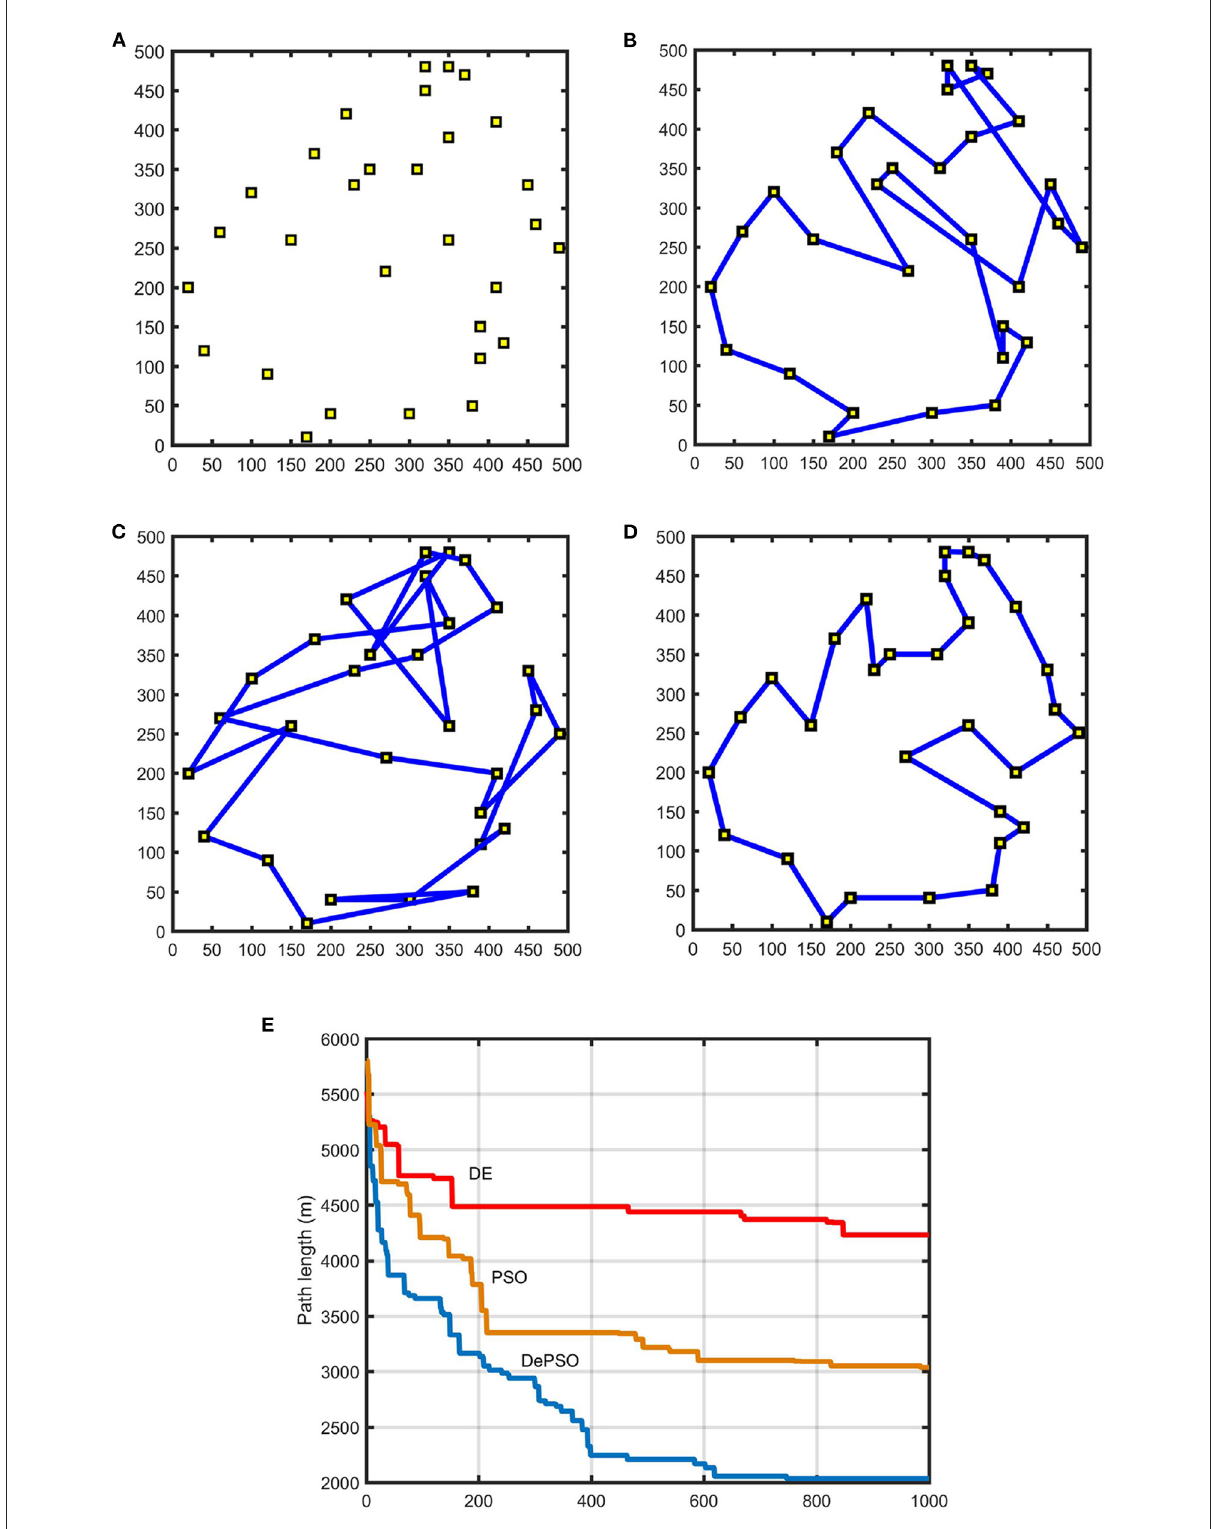
FIGURE7 Path planning results for 30 sampling points: (A) Distribution of 30 sampling points. (B) Path planning result with conventional PSO. (C) Path planning result with conventional DE. (D) Path planning result with DePSO. (E) Path length iterative process